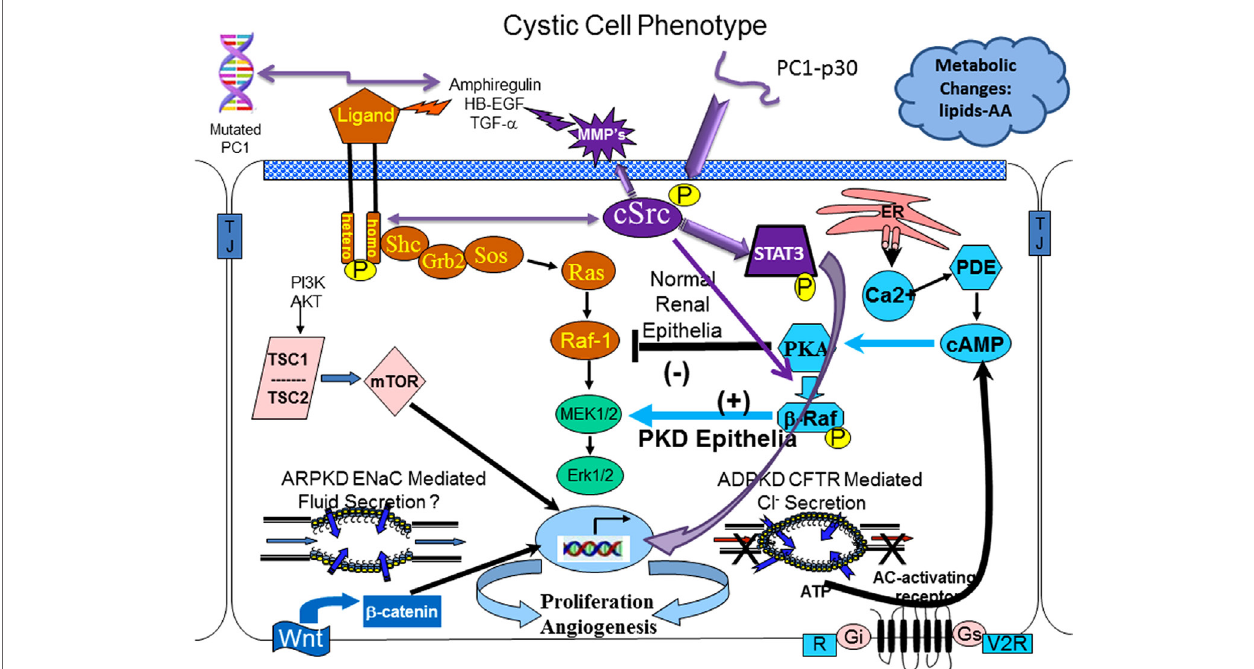
FiGURe 1 | The cystic cellular phenotype . This cartoon is an abridged composite of the abnormal signal transduction pathways reported to be active in polycystic kidney disease (PKD). Two main conduits that lead to unchecked proliferation are (1) the EGFR axis (orange path) and (2) a G-protein axis (aqua blue path) that leads to increased cyclic adenosine monophosphate (cAMP) and a switch in phenotypic response of renal epithelia to cAMP. The pathways suggest the following: in autosomal recessive polycystic kidney disease (ARPKD), an apical EGFR results in the axis becoming active resulting in reciprocal phosphorylation of the non-receptor tyrosine kinase cSrc (purple); in autosomal dominant polycystic kidney disease (ADPKD) a mutated polycystin 1 (PC1) leads to increase amphiregulin, activating EGFR, resulting in increased cSrc phosphorylation; in both ARPKD and ADPKD, cSrc activity (purple) alters the cellular response of cAMP resulting in proliferation; in addition, in ADPKD the cytoplasmic tail, PC1-p30 is overexpressed leading to acSrc-dependent activation of STAT3 by tyrosine phosphorylation. EGFR and cAMP signaling amplify the activation of cSrc/STAT3 by PC1-p30. Targeting proliferation will always be a requirement to effectively slow the progression of PKD and prevent the need for renal replacement therapy. Targeting single molecules that bridge both pathways (such as cSrc) is a logical approach to get maximum effectiveness with minimal dosing, thereby limiting toxicity. Pharmacological inhibition with a single compound that targets multiple pathways (such as a multi-kinase inhibitor—tesevatinib) should provide a similar benefit. However, no single compound will provide lifetime effectiveness. Effective therapy will require multiple compounds administered in a disease stage-specific manner that will need to be individualized, accounting for variations in disease severity and rate of